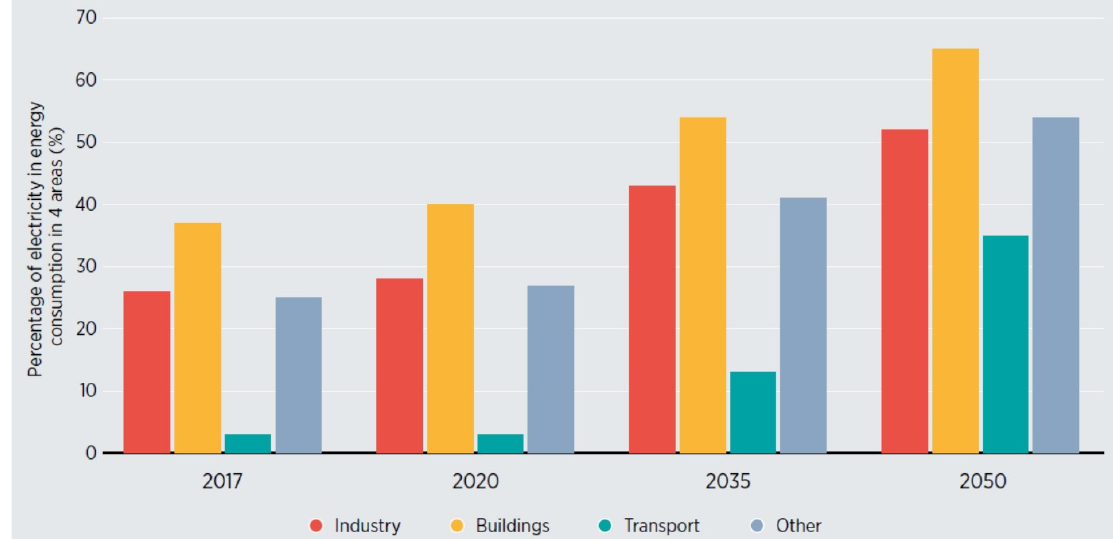
Figure 6. IRENA’s forecast of electrification rate of different sectors by 2050 (Electrification Scenario) [20].